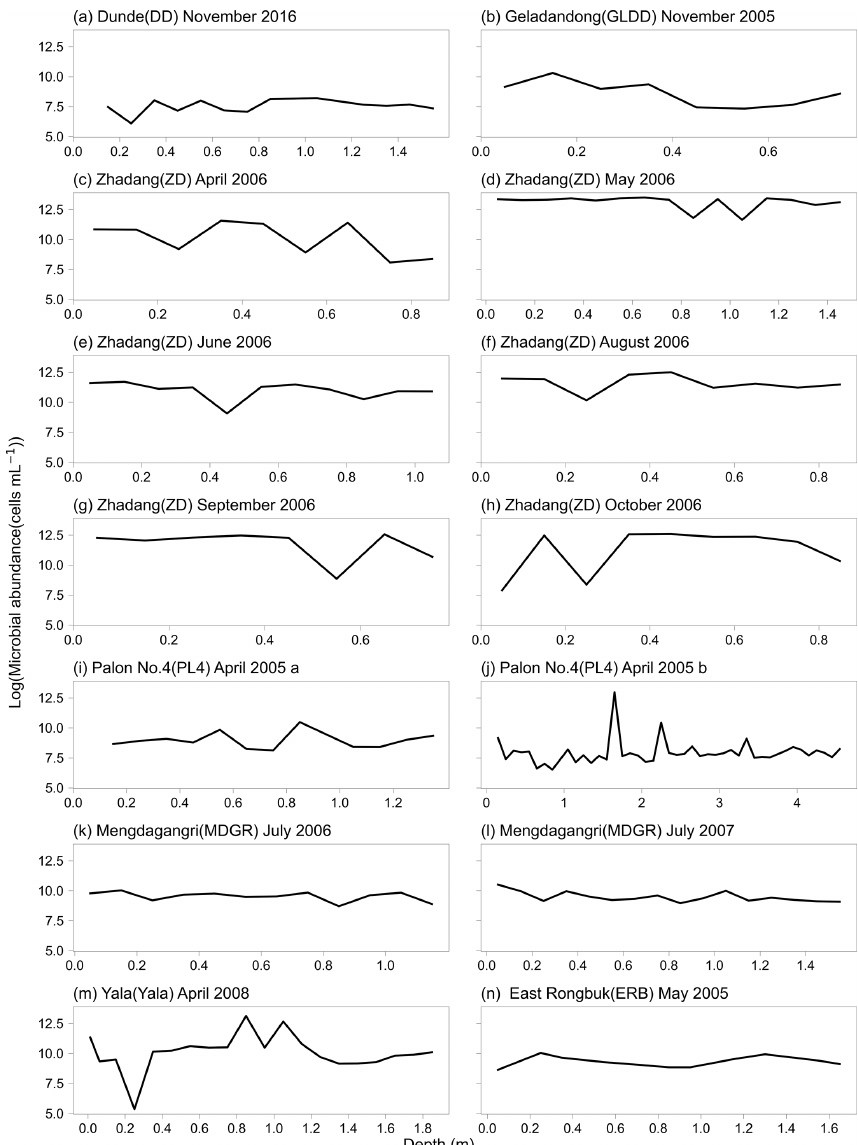
Figure 4. The variation of microbial abundance with depth in each sampled snow pit. The abundance is